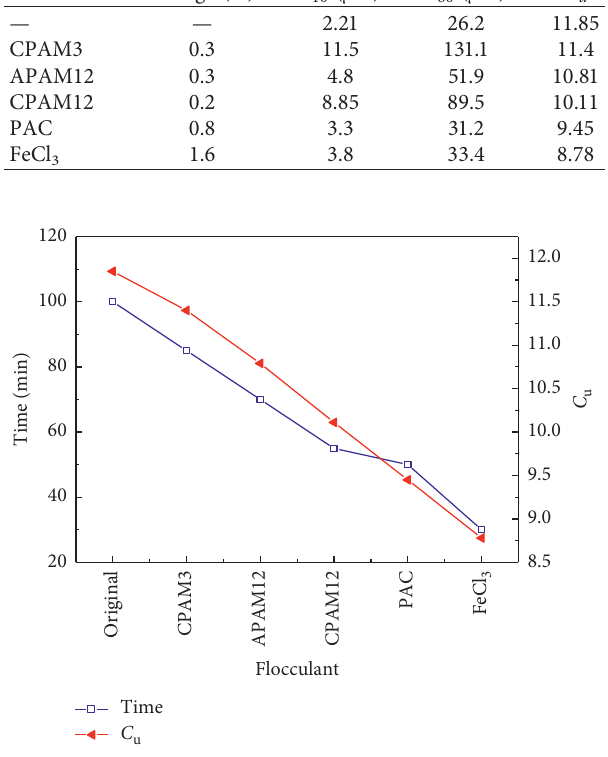
Figure 16: Change curve of the time required for pressure filtration to reach stability and of the nonuniformity coefficient for different flocculation treatments (original refers to slurry without adding